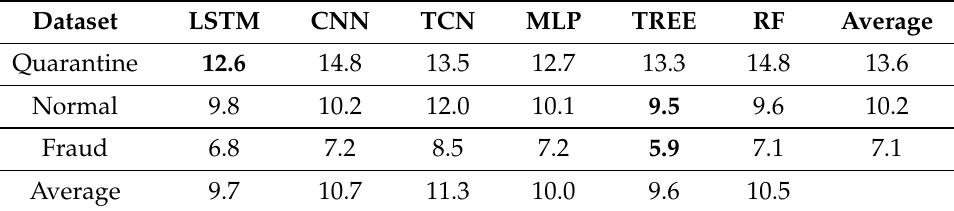
Table 12. MAPE results for each period and each model. The results have been obtained after choosing the best set of parameters for each case by carrying out a parameter optimization process. The last row and column correspond to the means for each model and dataset, respectively. The best model for each dataset is specified in bold.